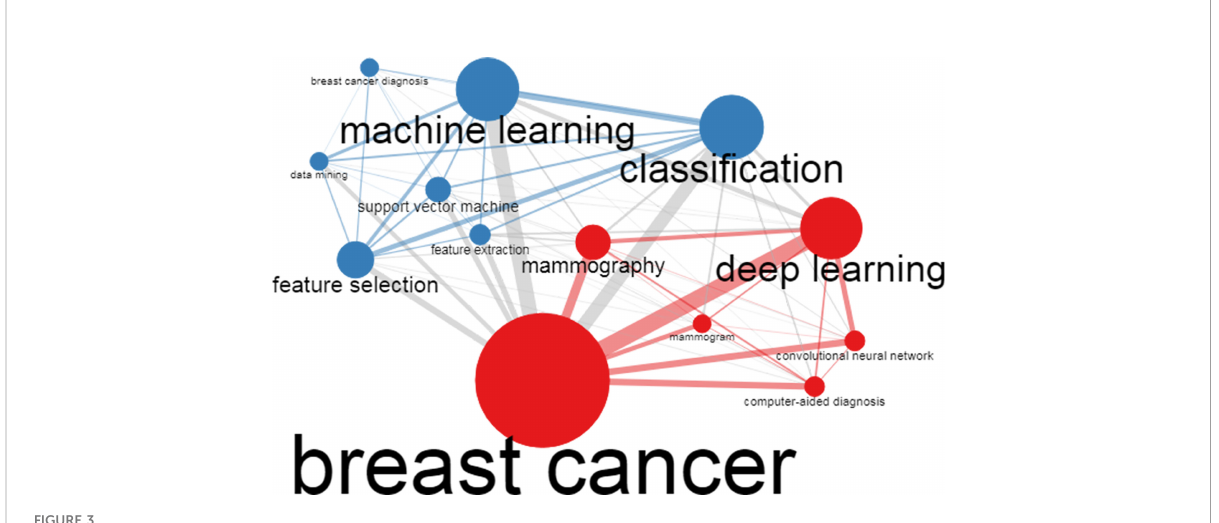
FIGURE 3 A co-occurrence network analysis of author